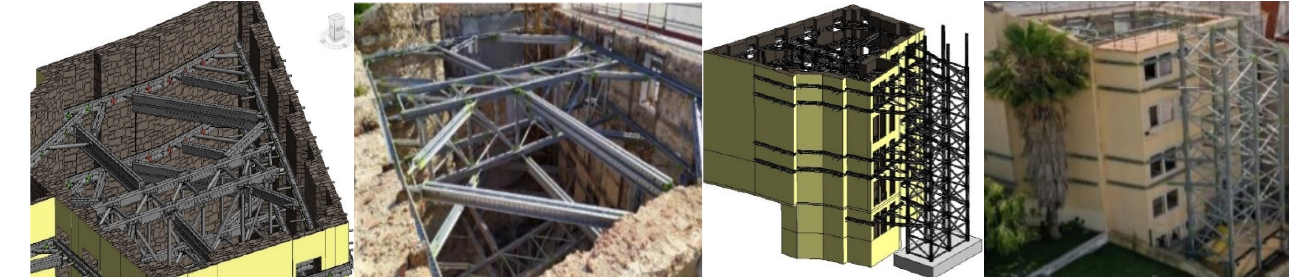
Figure 12. Comparison of the BIM model with the real construction